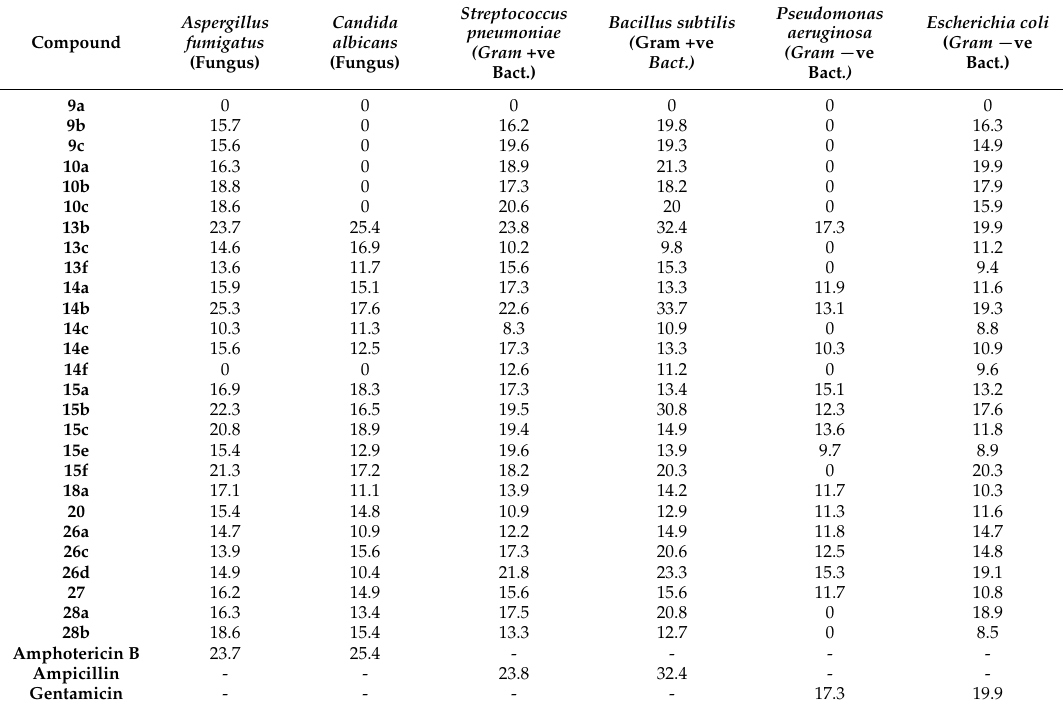
Table 1. Mean zone of inhibition beyond well diameter (6 mm) produced on a range of clinically pathogenic microorganisms using (5 mg/mL) concentration of tested